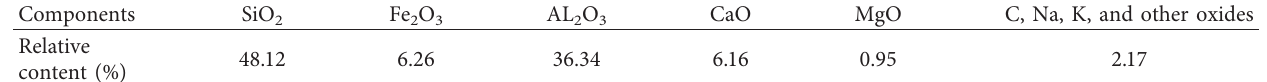
Table 2: Relative contents of chemical constituents of coal